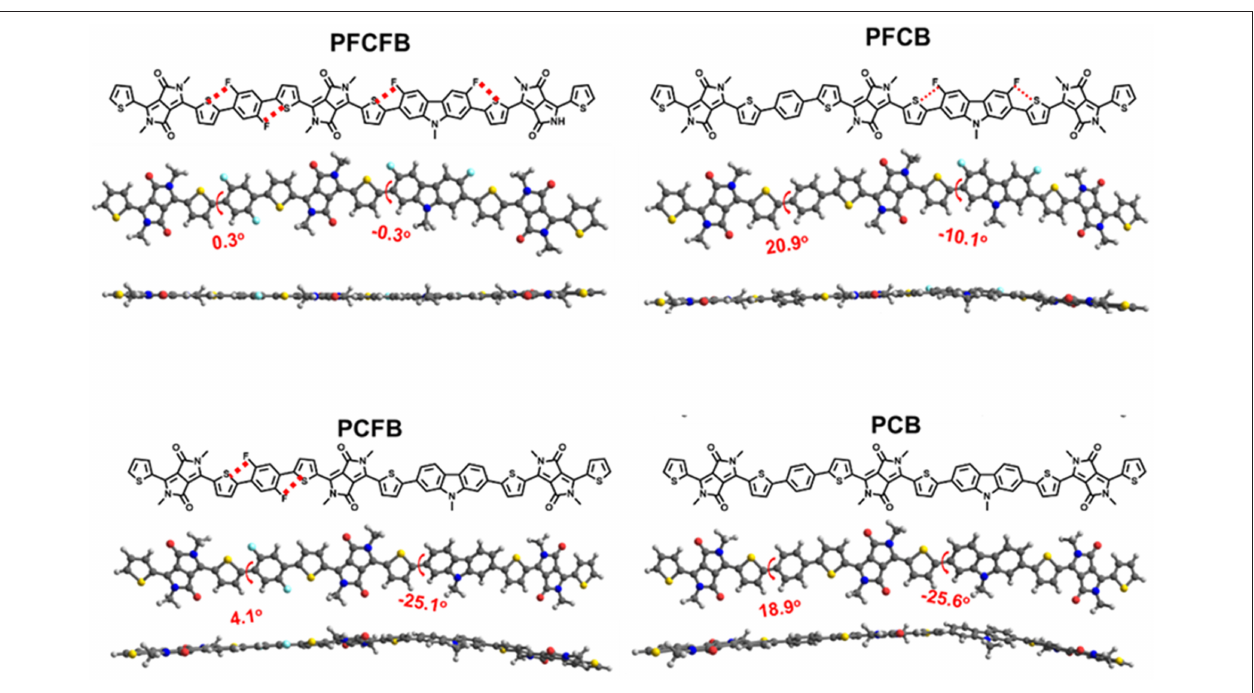
FIGURE 2 | Optimized chemical geometries of the simplified repeating units using DFT at the B3LYP/6-31G(d)